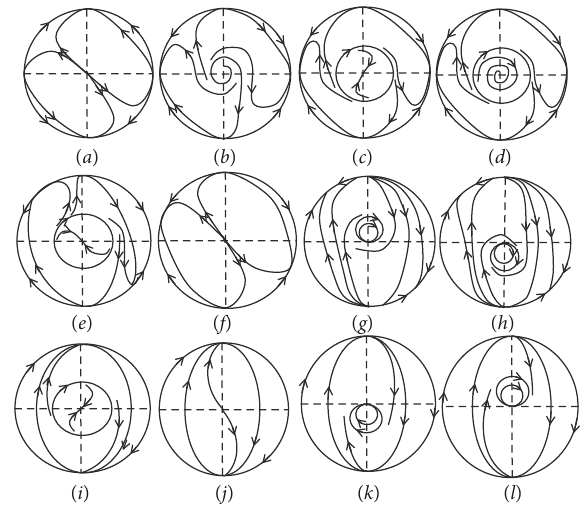
Figure 2: The global phase portraits of system (4) as the parameter 𝑎 < 0